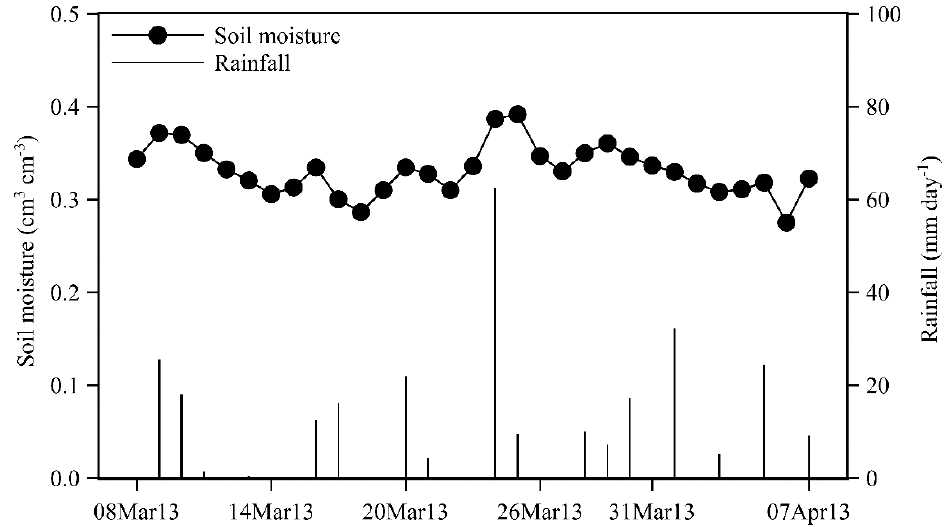
Figure A1. Soil moisture (cm 3 cm − 3 ) and rainfall (mm day − 1 ) in the study period.